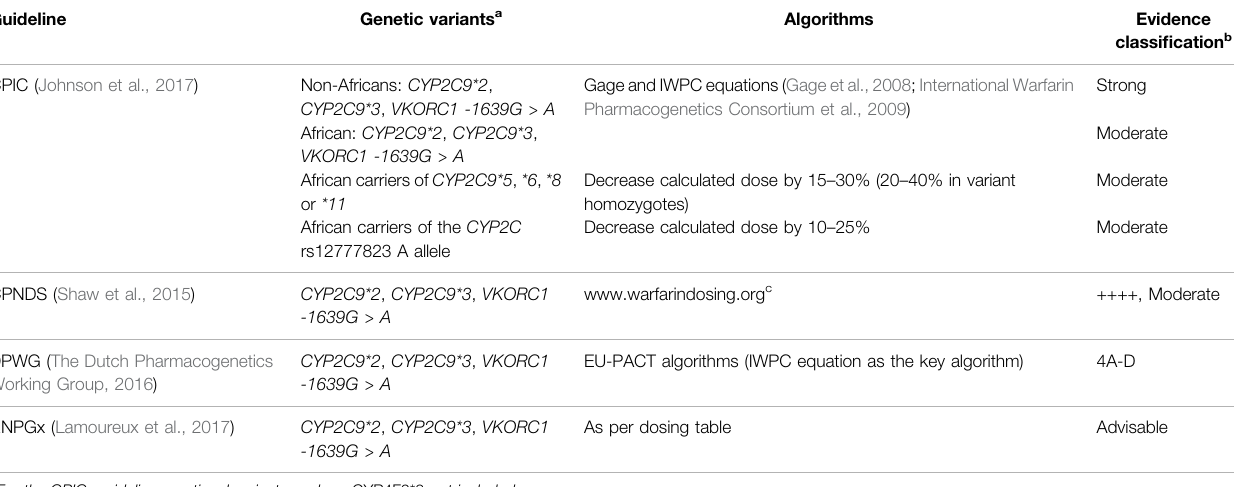
TABLE 3 | Clinical implementation guidelines (Abdullah-Koolmees et al., 2020).